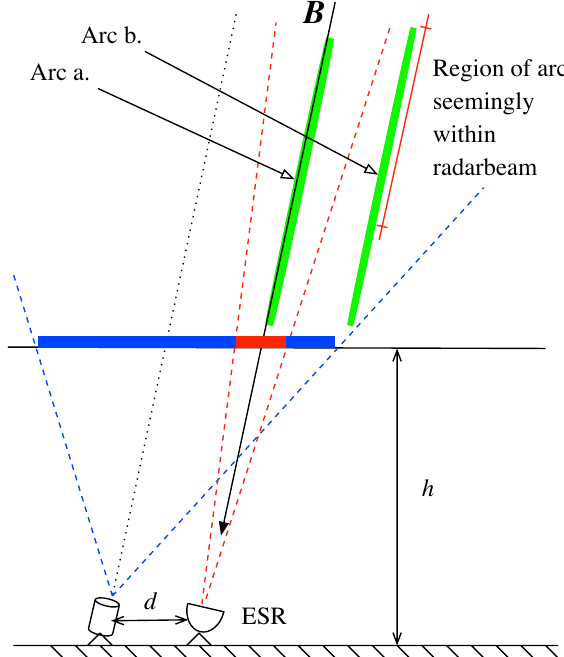
Fig. 6. Simple drawing depicting the experimental setup, highlight- ing the difficulties due to the distance between the two instruments. The camera (drawn as a cylinder) is located 7km from the radar, al- most directly north of it. Both the camera and the radar are pointing along the